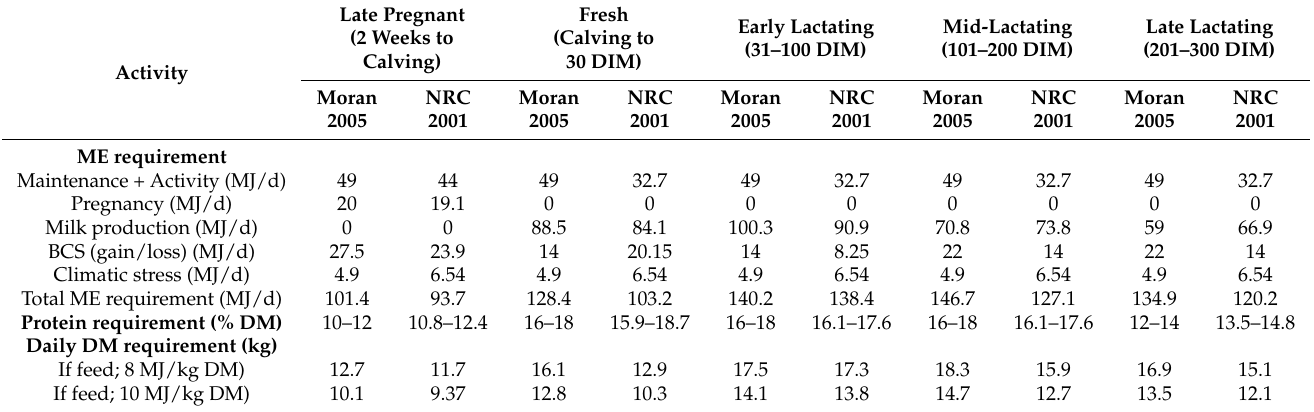
Table 7. Metabolisable energy (MJ ME/d), protein (% dry matter (DM)), and DM/d (kg) requirements for dairy cows at the late pregnant, fresh, early lactating, mid-lactating, and late lactating